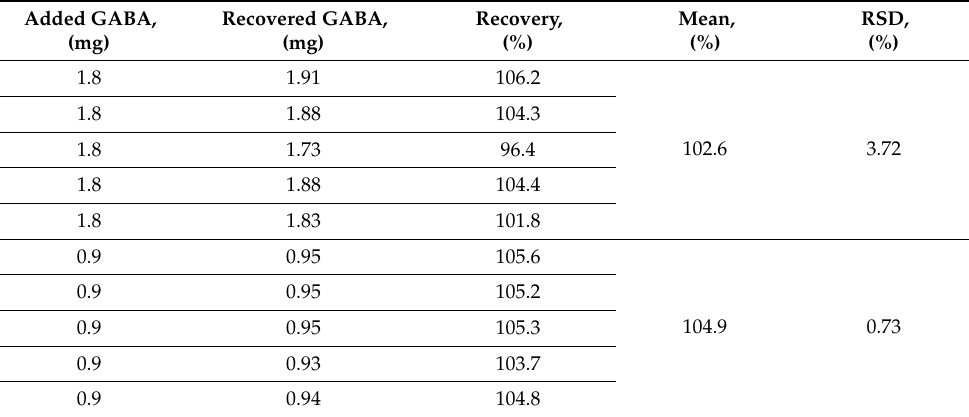
Table 2. Repeatability and accuracy for GABA in potato ( n = 5).